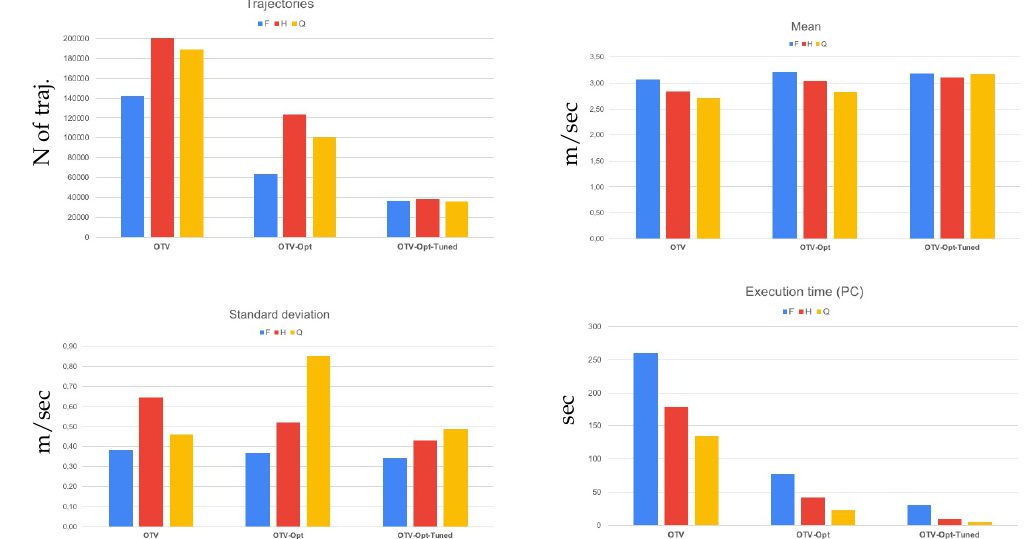
Figure 7. Comparison between the original OTV algorithm, on the left, and its optimized counterpart obtained by the functional analysis, on the right, on three frames (100, 200 and 300) of the 20-s sequence acquired on the Brenta river in Italy.